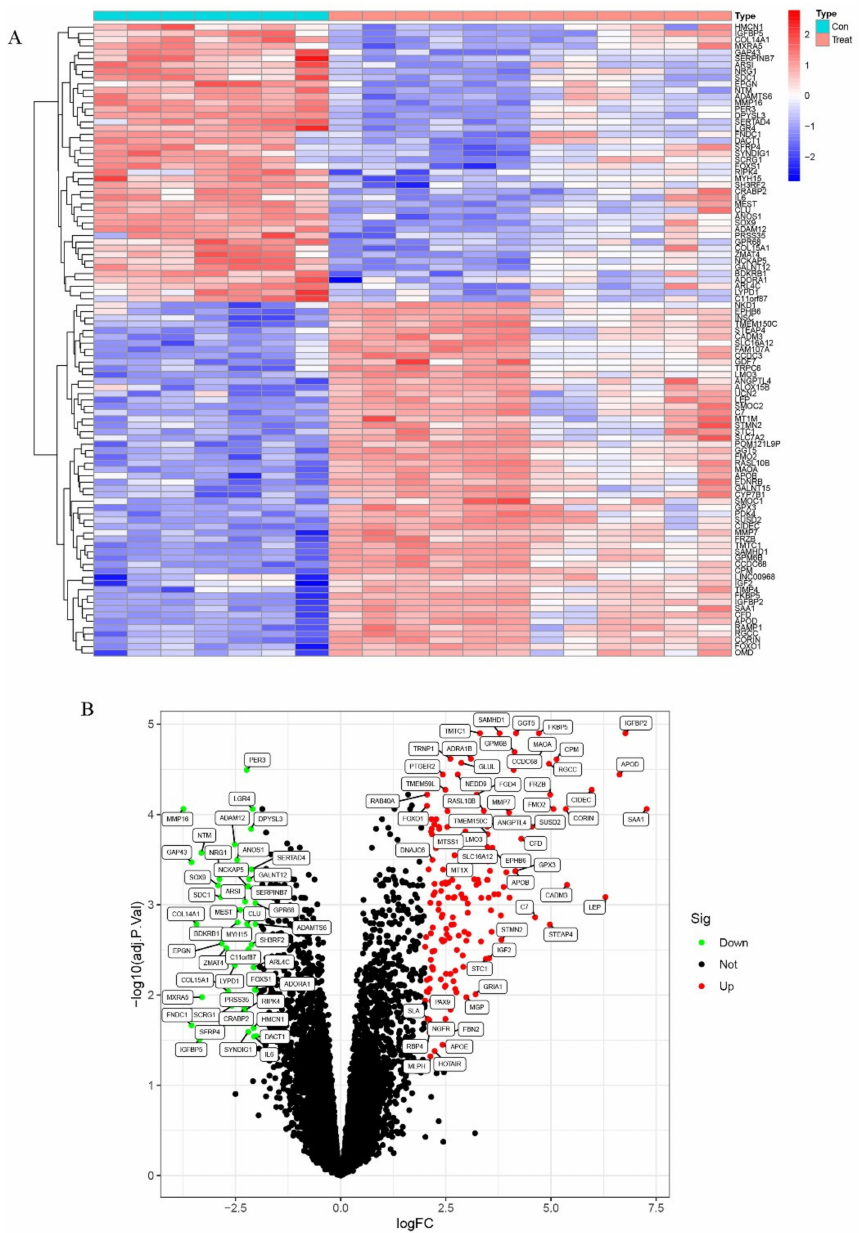
Figure 2. The expression characteristics of genes in osteogenic − induced mesenchymal stem cells (treat group) and uninduced mesenchymal stem cells (control group). ( A ) Heatmap presented the overall expression of genes with FDR < 0.05 in treat and control group. ( B ) Volcano plot visualized the upregulated (red) and downregulated (blue) genes in treat and control